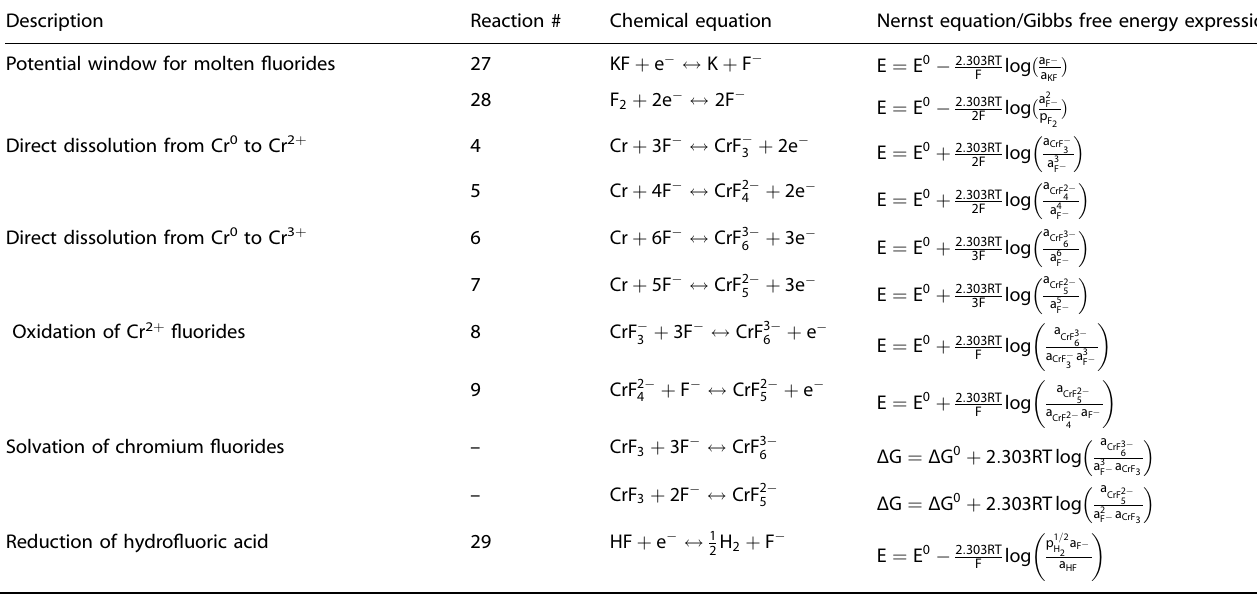
Table 3. Equilibrium redox reactions and their thermodynamic expression utilized for the construction of potential concentration diagrams in molten fl uoride salts.